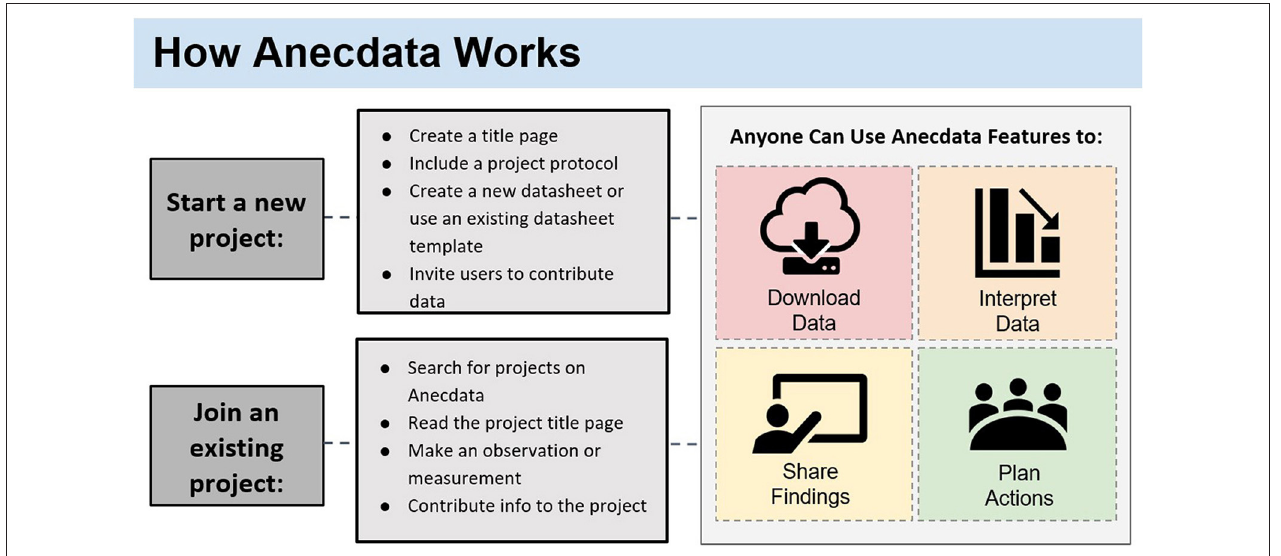
FIGURE 1 | How Anecdata works. Anecdata is a citizen science platform that welcomes new projects, some of which are open to new participants joining. Anyone can download non-private data for analysis and interpretation, share the data with others, and use the data to plan actions aimed at effecting change at any societal level.